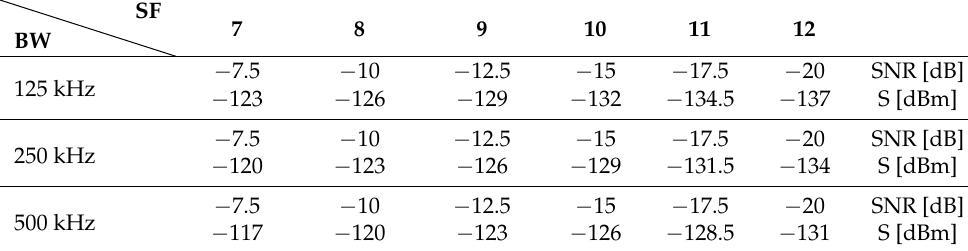
Table 3. SNR and S, in dependence on BW and SF.